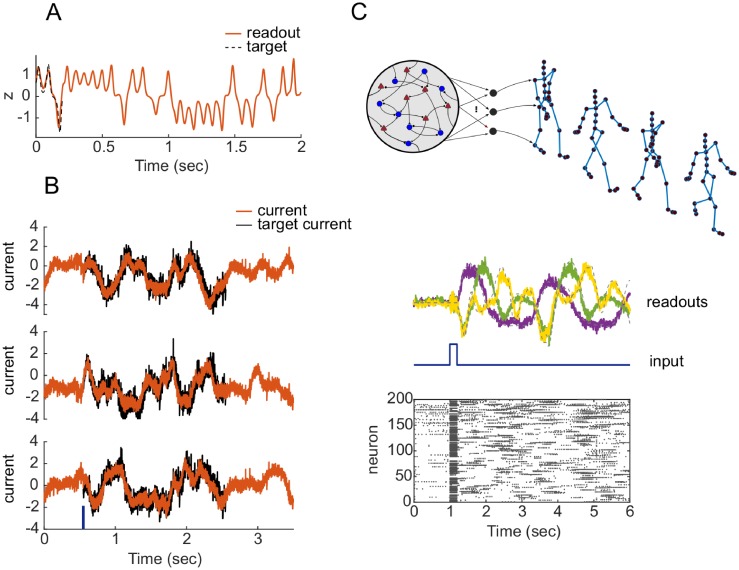
Learning chaotic trajectories and complex transient activity.A: Output of a rate network (N = 1000, halftanh activation function) trained to produce the time course of the first coordinate of a Lorenz attractor (σ = 10, ρ = 28, β = 2.67). B: Input currents onto three representative neurons in a balanced spiking network trained to reproduce innate current trajectories of duration 2 s after a brief stimulus (50 ms) at time 0.5 s. Network size N = 500, synaptic time constant τs = 50 ms. C: Balanced E/I spiking network producing walking behavior in response to a strong input pulse of duration 100 ms. Top: a pictorial representation of the network with 56 distinct readouts (network size N = 300; synaptic time constant τs = 50 ms). Middle: activity of three random readout units over the course of ∼ 6 s. Bottom: spike raster plot of 200 neurons in the network.